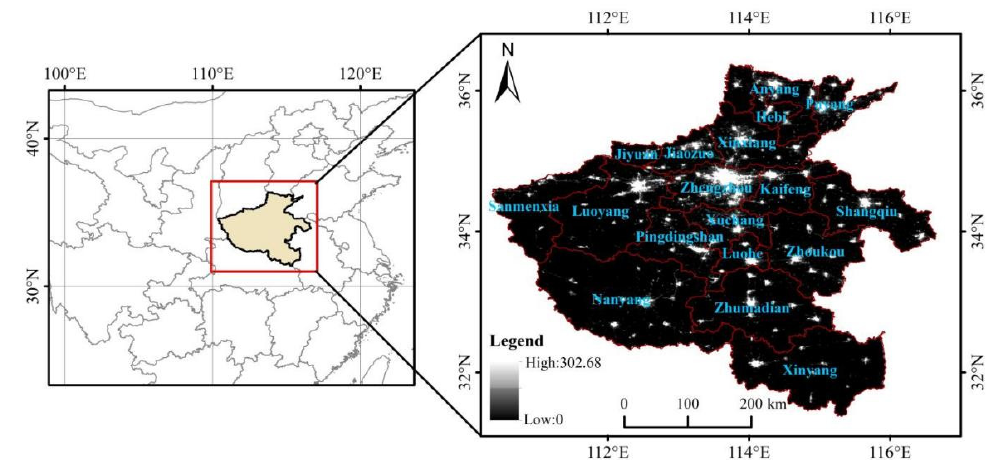
Figure 1. The location and nighttime light from the NPP-VIIRS-like NTL data (2018) of the study